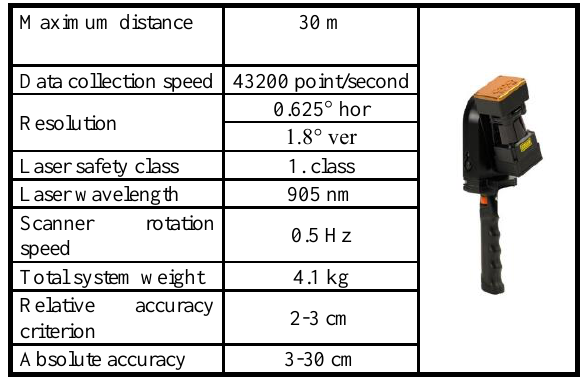
Table 2. GeoSLAM Zeb-Revo System Technical